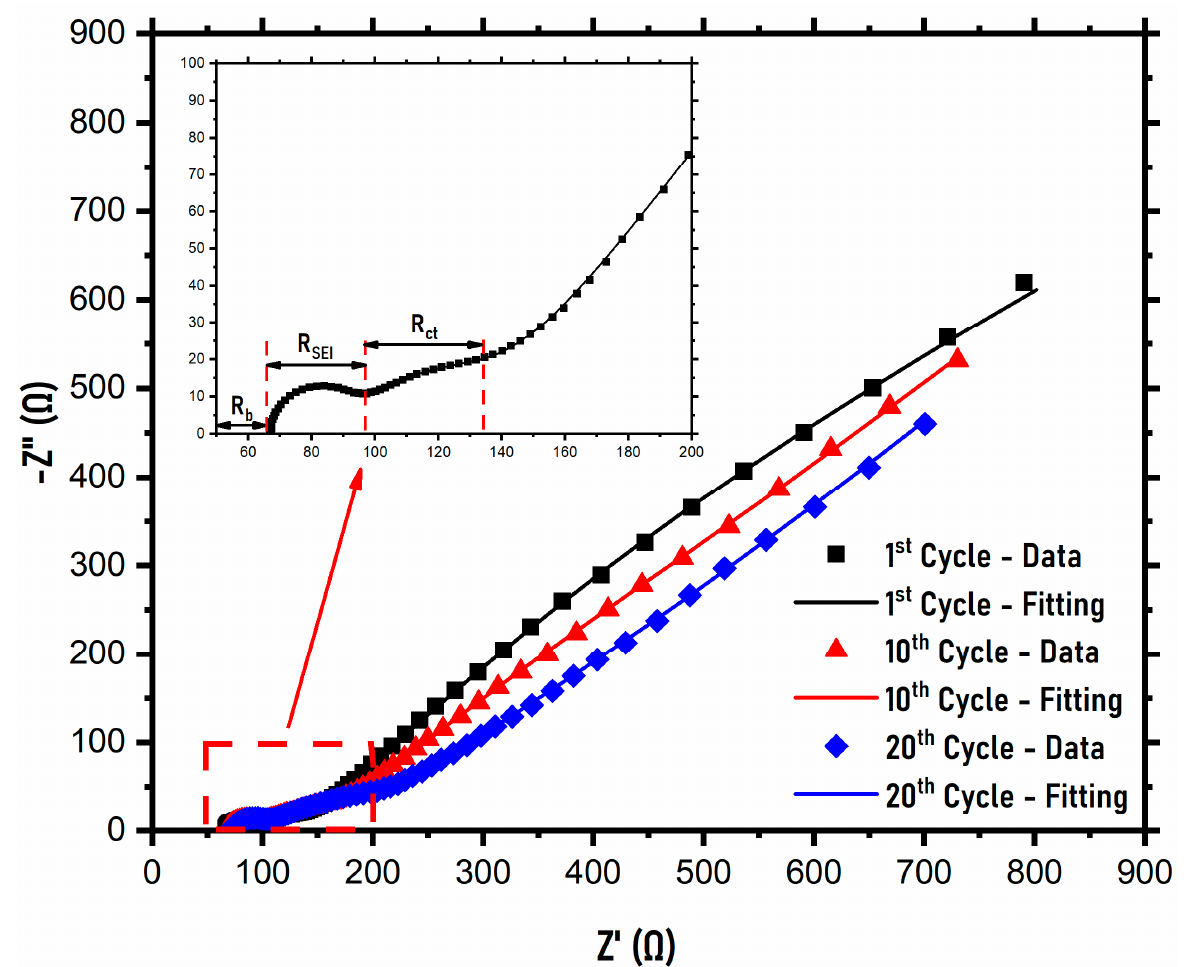
Figure 6. EIS spectra after the 1st, 10th, and 20th cycles at 1 C rate. The postmortem analysis of the NVPF symmetric cell after 1000 cycles at a 1 C rate is shown in Figure 7. The XRD spectrum of the pristine, the anode, and the cathode after